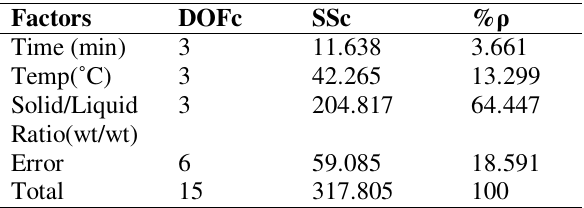
ANOVA for the Platinum leaching by aqua regia solution for each controlled factor.